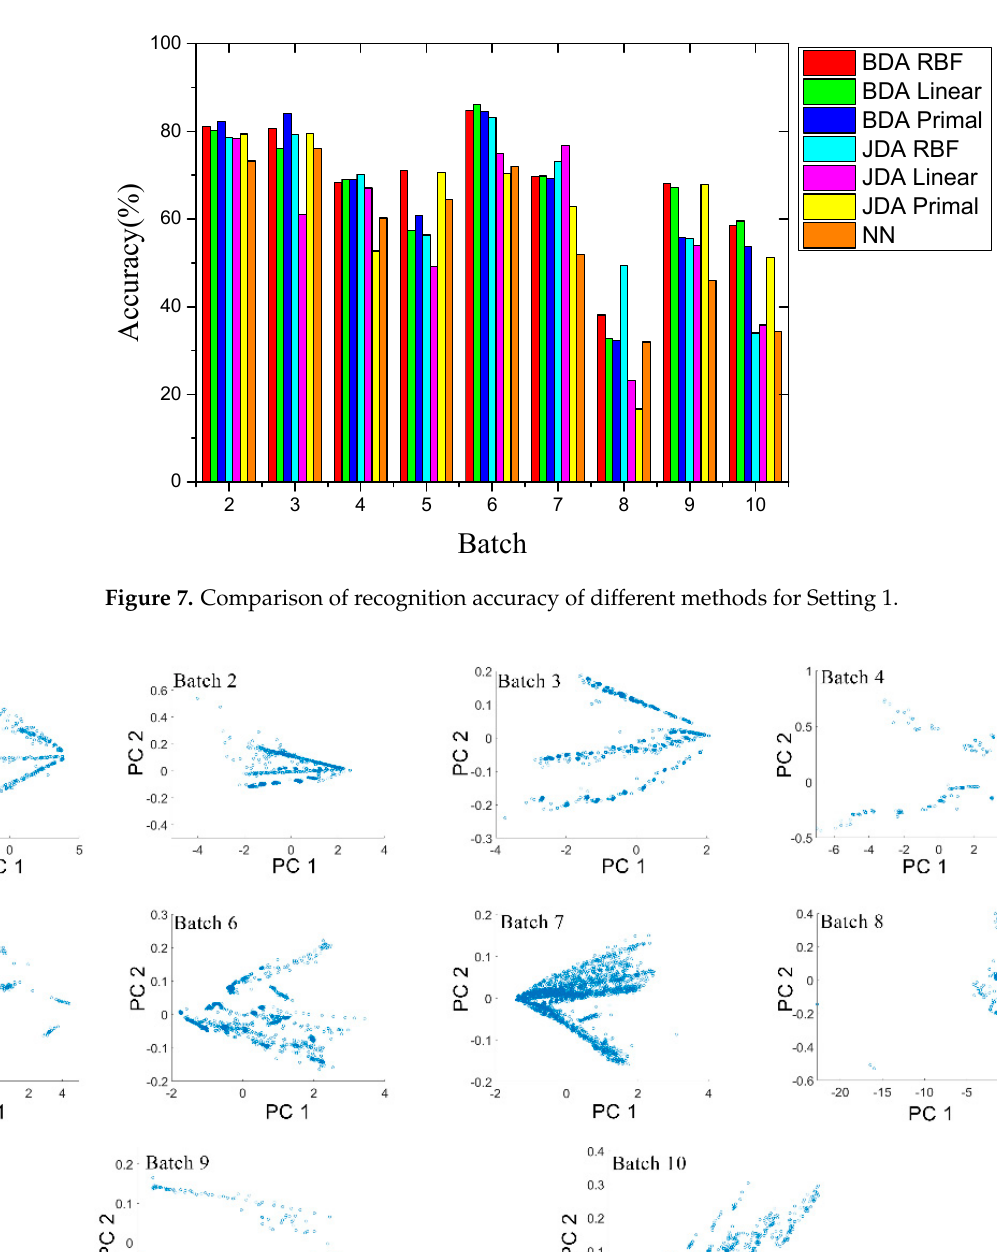
Table5. Drift compensation results of BDA and other methods for Setting 1.